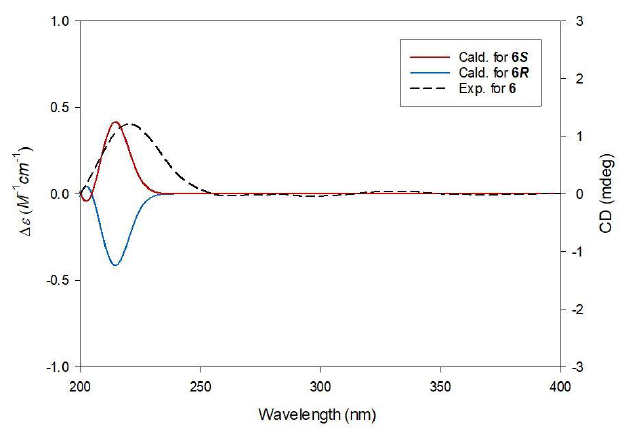
Figure 5. Experimental and calculated ECD spectra of 6 .